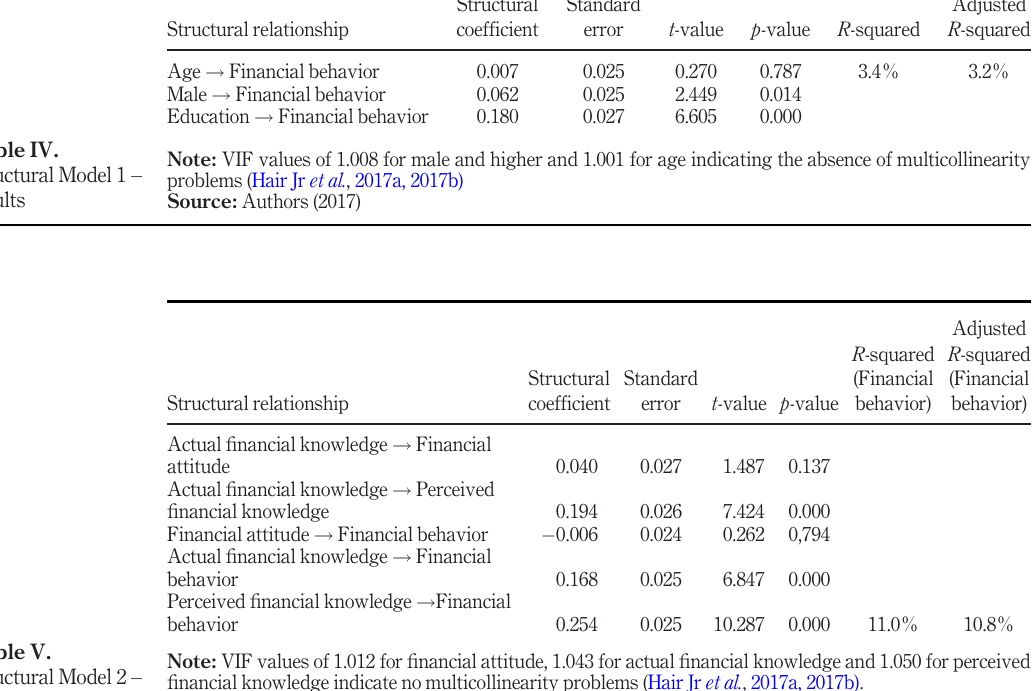
Structural relationship